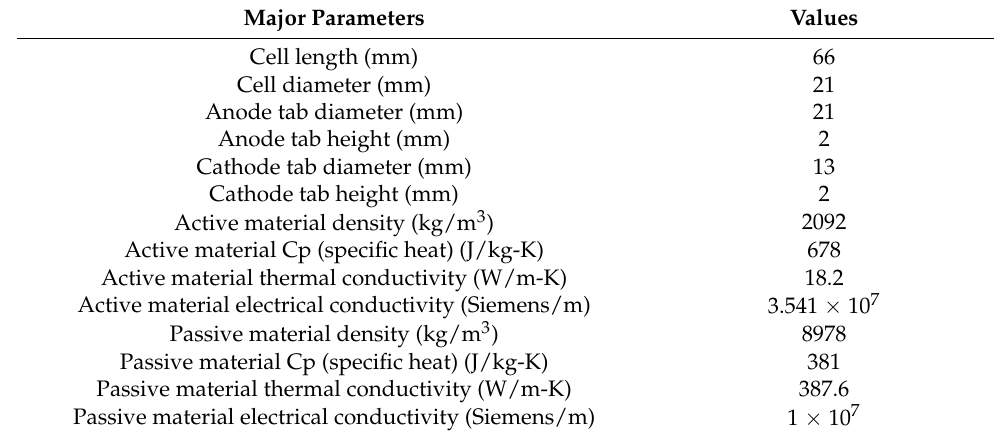
Table 1. Dimensions and parameters of the 21,700 cylindrical Lithium-ion battery cell in this study. Major Parameters